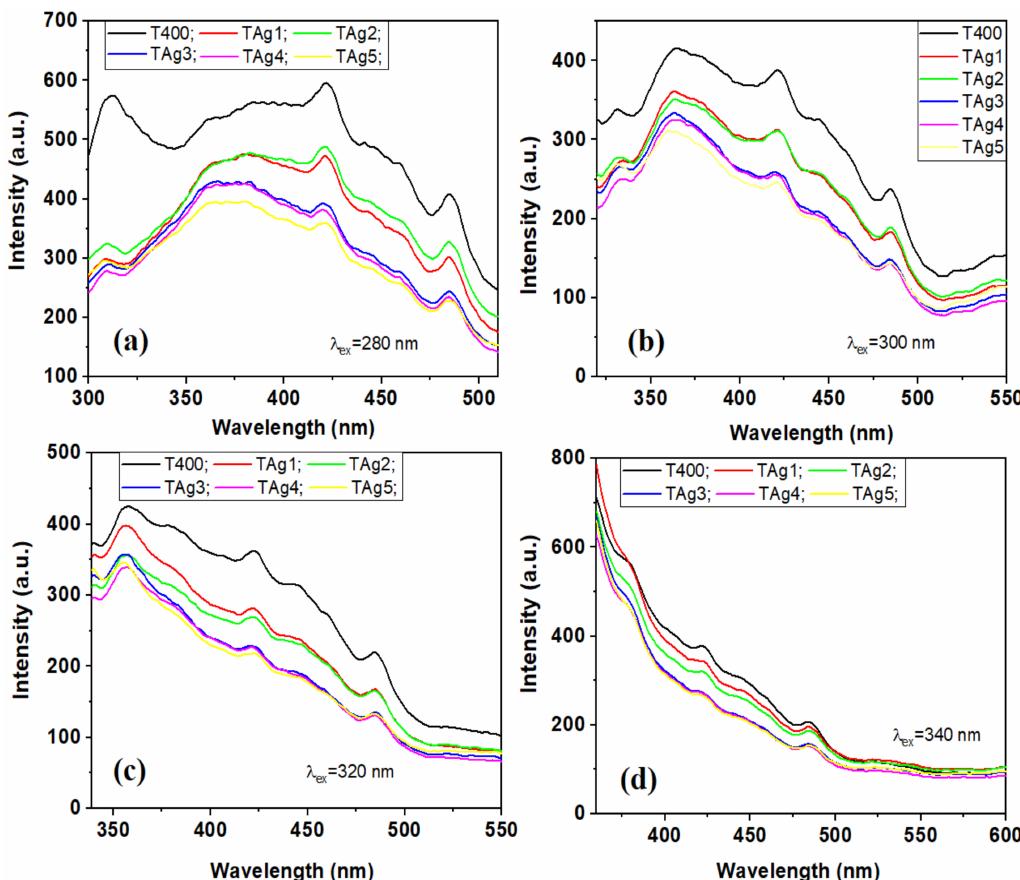
Figure 7. Emission spectra of pure TiO 2 and Ag–TiO 2 nanostructured nanofibers at different excitation wavelengths λ ex = 280 nm ( a ), 300 nm ( b ), 320 nm ( c ) and 340 nm ( d